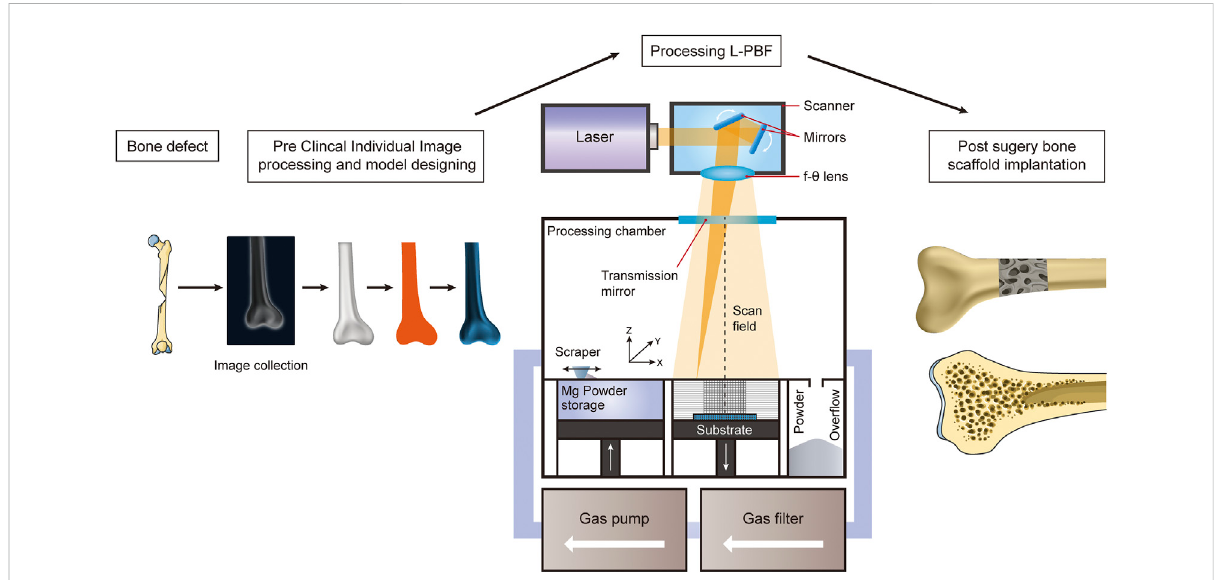
FIGURE 3 Schematic diagram illustrating the AM of Mg-alloys for the treatment of bone defects using the L-PBF technique.